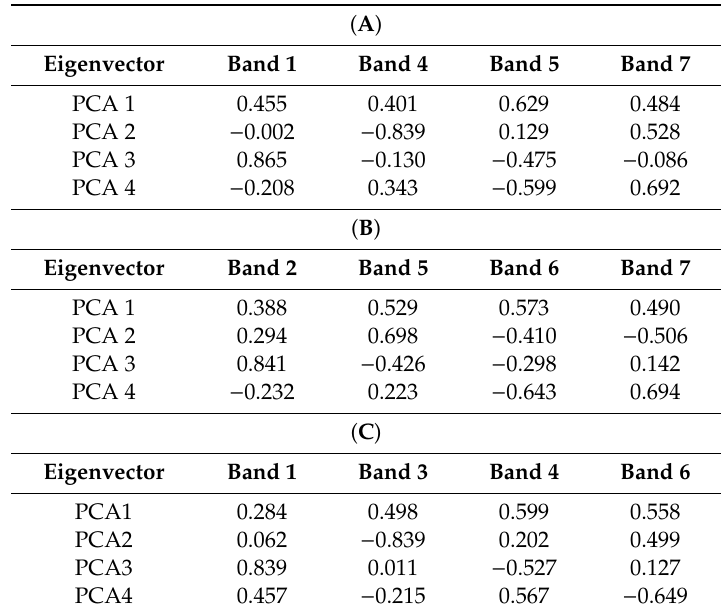
Table 4. The Eigenvector matrix values derived from PCA for mapping hydroxyl-bearing minerals. ( A ) Bands 1, 4, 5 and 7 of Landsat-7 ETM ++ ; ( B ) Bands 2, 5, 6 and 7 of Landsat-8; and ( C ) Bands 1, 3, 4 and 6 of ASTER.